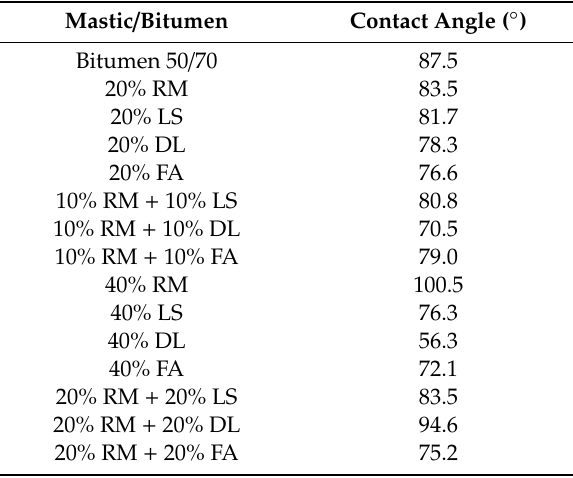
Table 5. Samples that required adhesion improver agent.